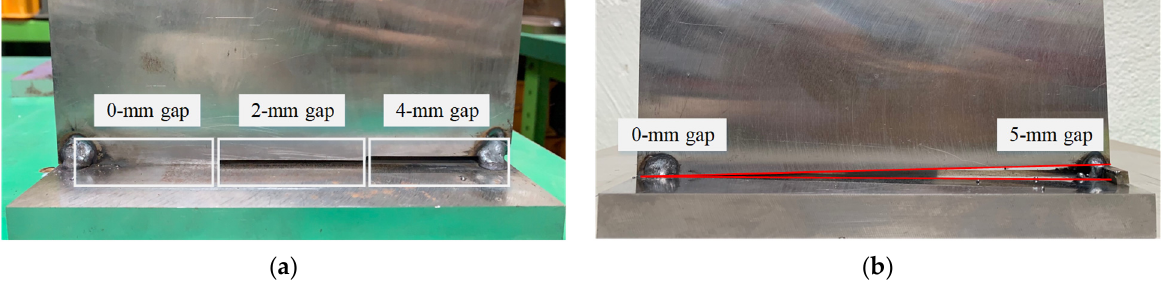
Figure 9 . Frame designation of welding current data: ( a ) the test plate used for offline verification and ( b ) the test plate used for online verification.